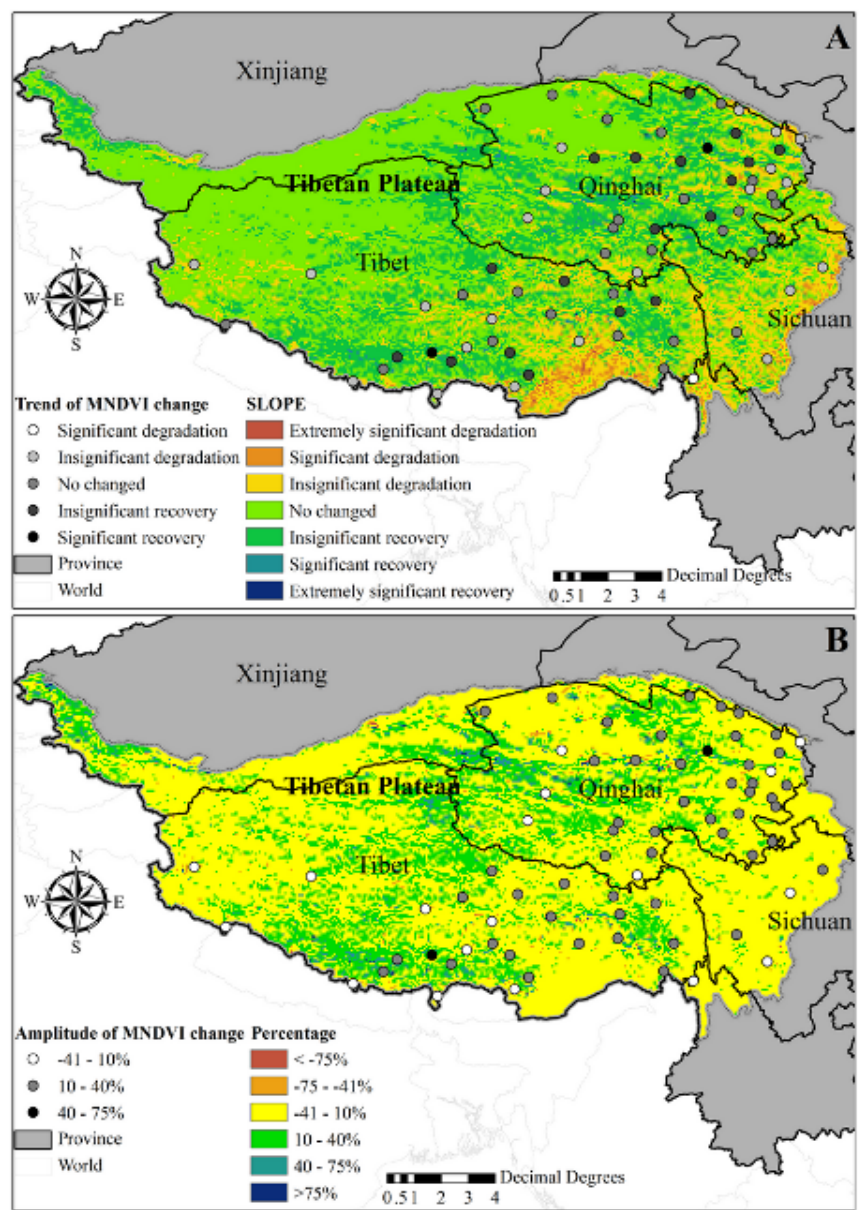
Figure 4. The simulated trend of ( A ) MNDVI and its changed scope of percentage in comparison with ( B ) the average MNDVI in the Tibetan Plateau from 1982 to 2006. The black solid circles denote the variations of A and B from 72 observatory